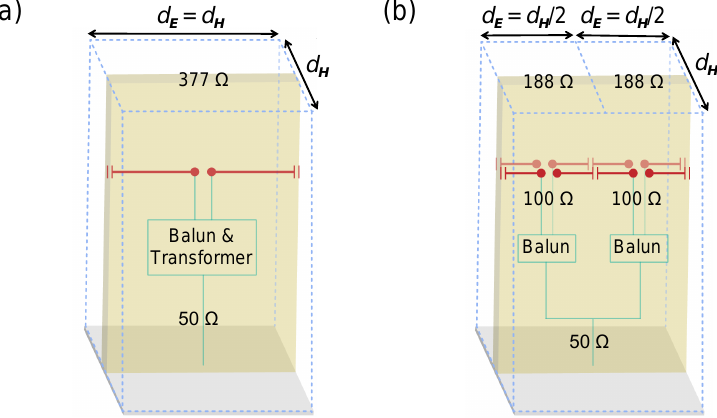
Figure 3. Presentation of the impedance-matching process. ( a ) Square unit cell with a single dipole; ( b ) Split unit cell with parallel dual